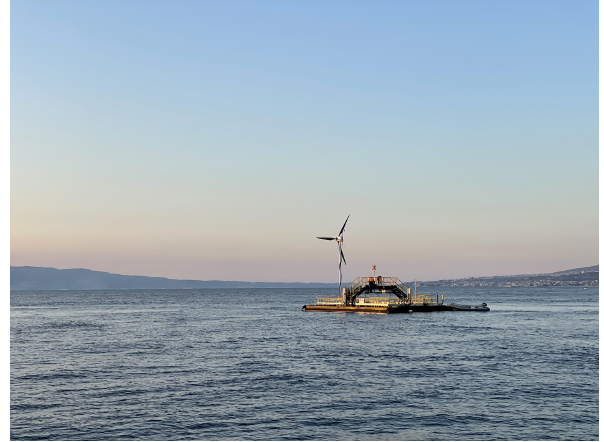
Figure 2. The multipurpose